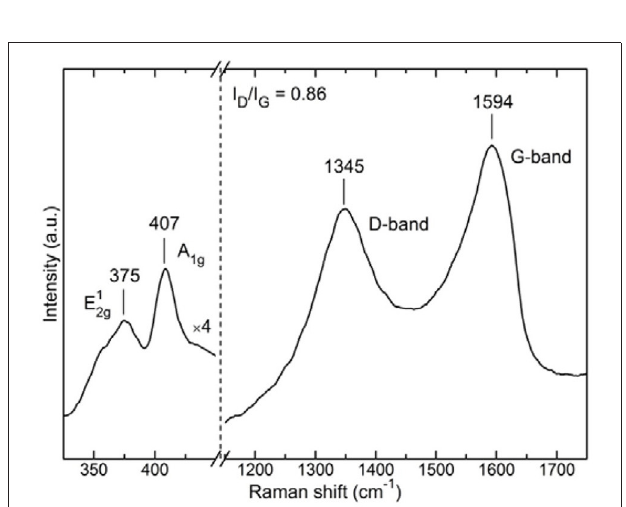
FIGURE 6 | Raman spectrum of the MoS 2 /r-GO nanocomposite.